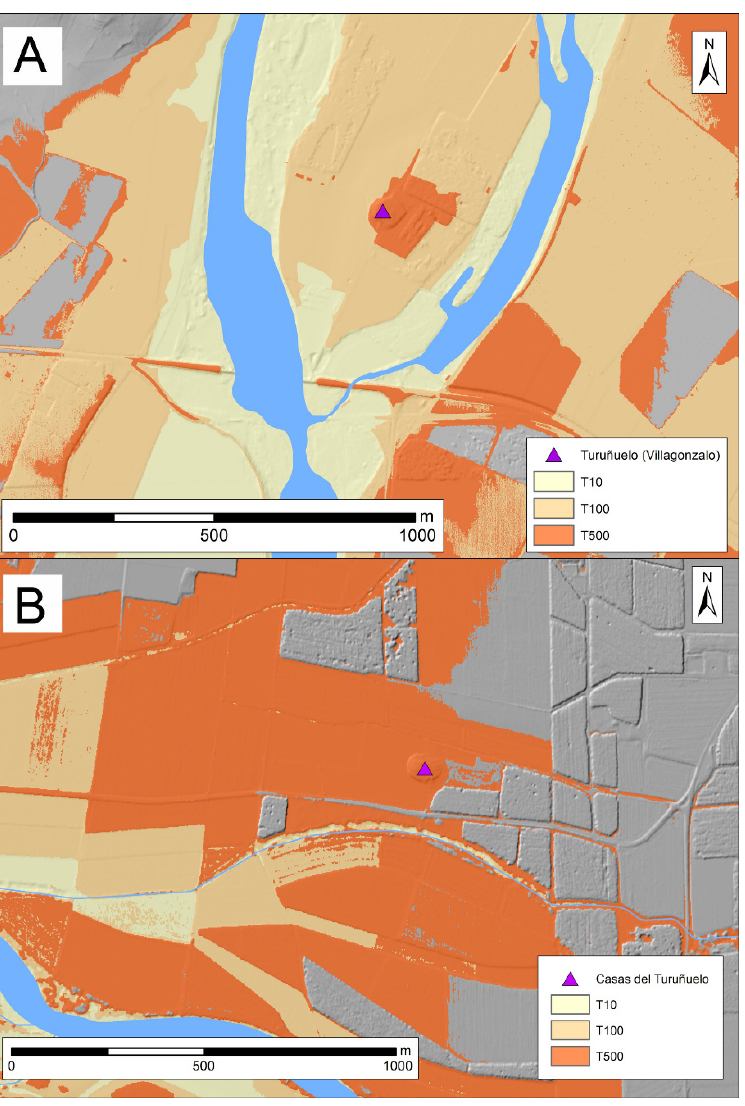
Figure 19. Models obtained from the APSFR analysis of the tumuli of El Turuñuelo (Villagonzalo, Badajoz, Spain) ( A ) and Casas del Turuñuelo (Guareña, Badajoz, Spain) ( B ) showing how the T500 event affected both the buildings and their surrounding land.